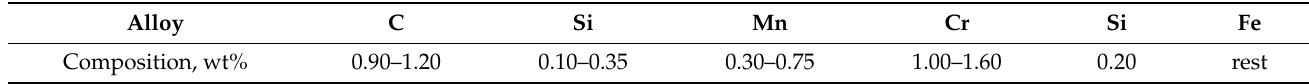
Table 3. EN-31 steel,